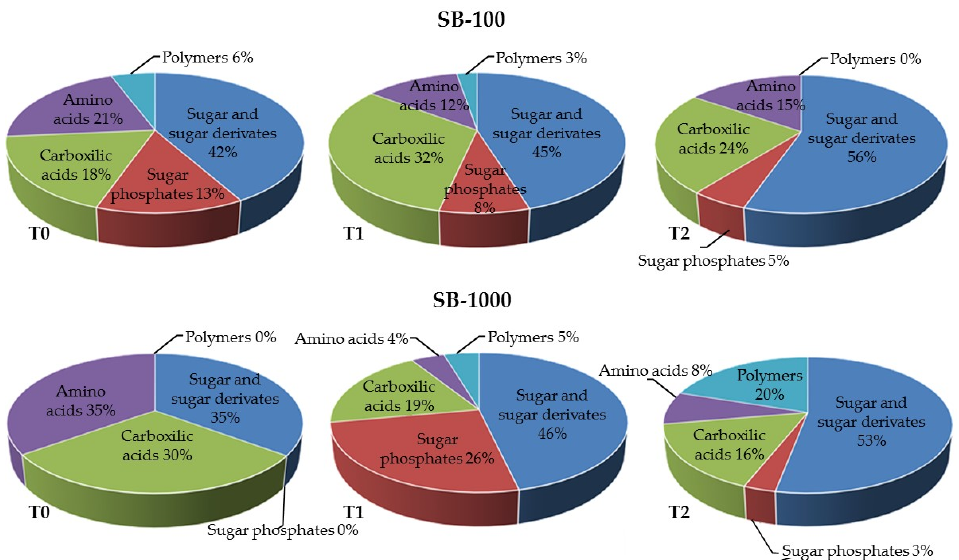
Figure 5. Use of different C-source guilds by microbial communities in amended and unamended Sb-polluted SB soils. Average percentage values relative to the 120 h incubation time are reported. T0, T1 and T2 refer to MSWC addition, i.e., 0, 1 and 2%, respectively. For overall metabolic activity of the different microbial communities see Figure